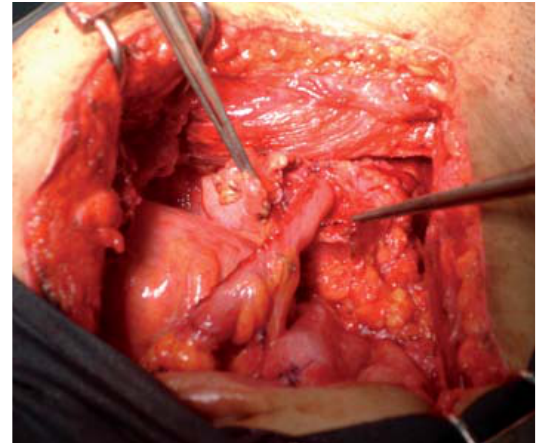
Figure 4 - Anastomosis of the ileal tube to bladder